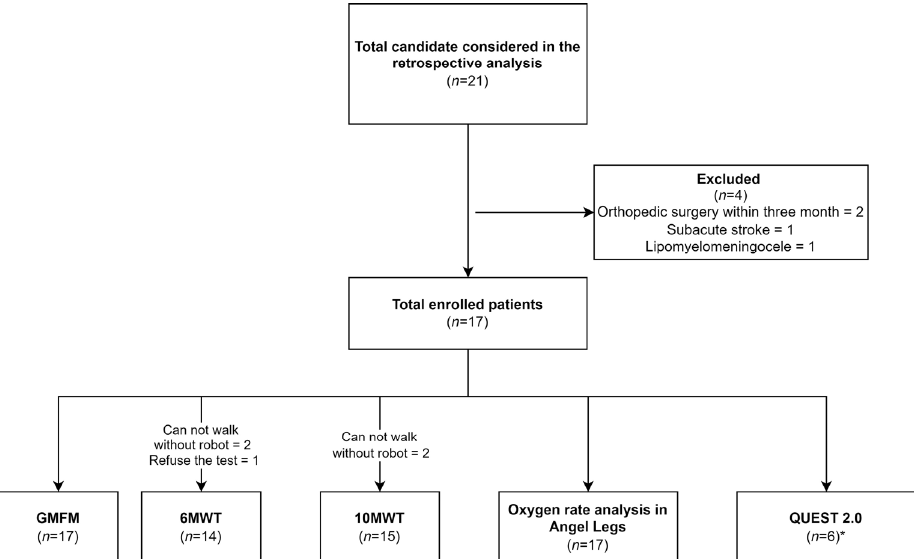
Figure 3. Schematic diagram of the evaluation, including the robot-assisted gait training protocol in this study. * Low sample size owing to the starting period of this evaluation tool; 6 MWT, 6-min walk test; 10 MWT, 10-m walk test; GMFM, Gross Motor Function Measures; QUEST 2.0, Quebec User Evaluation of Satisfaction with assistive Technology 2.0. Table 1. General characteristics of the participants.